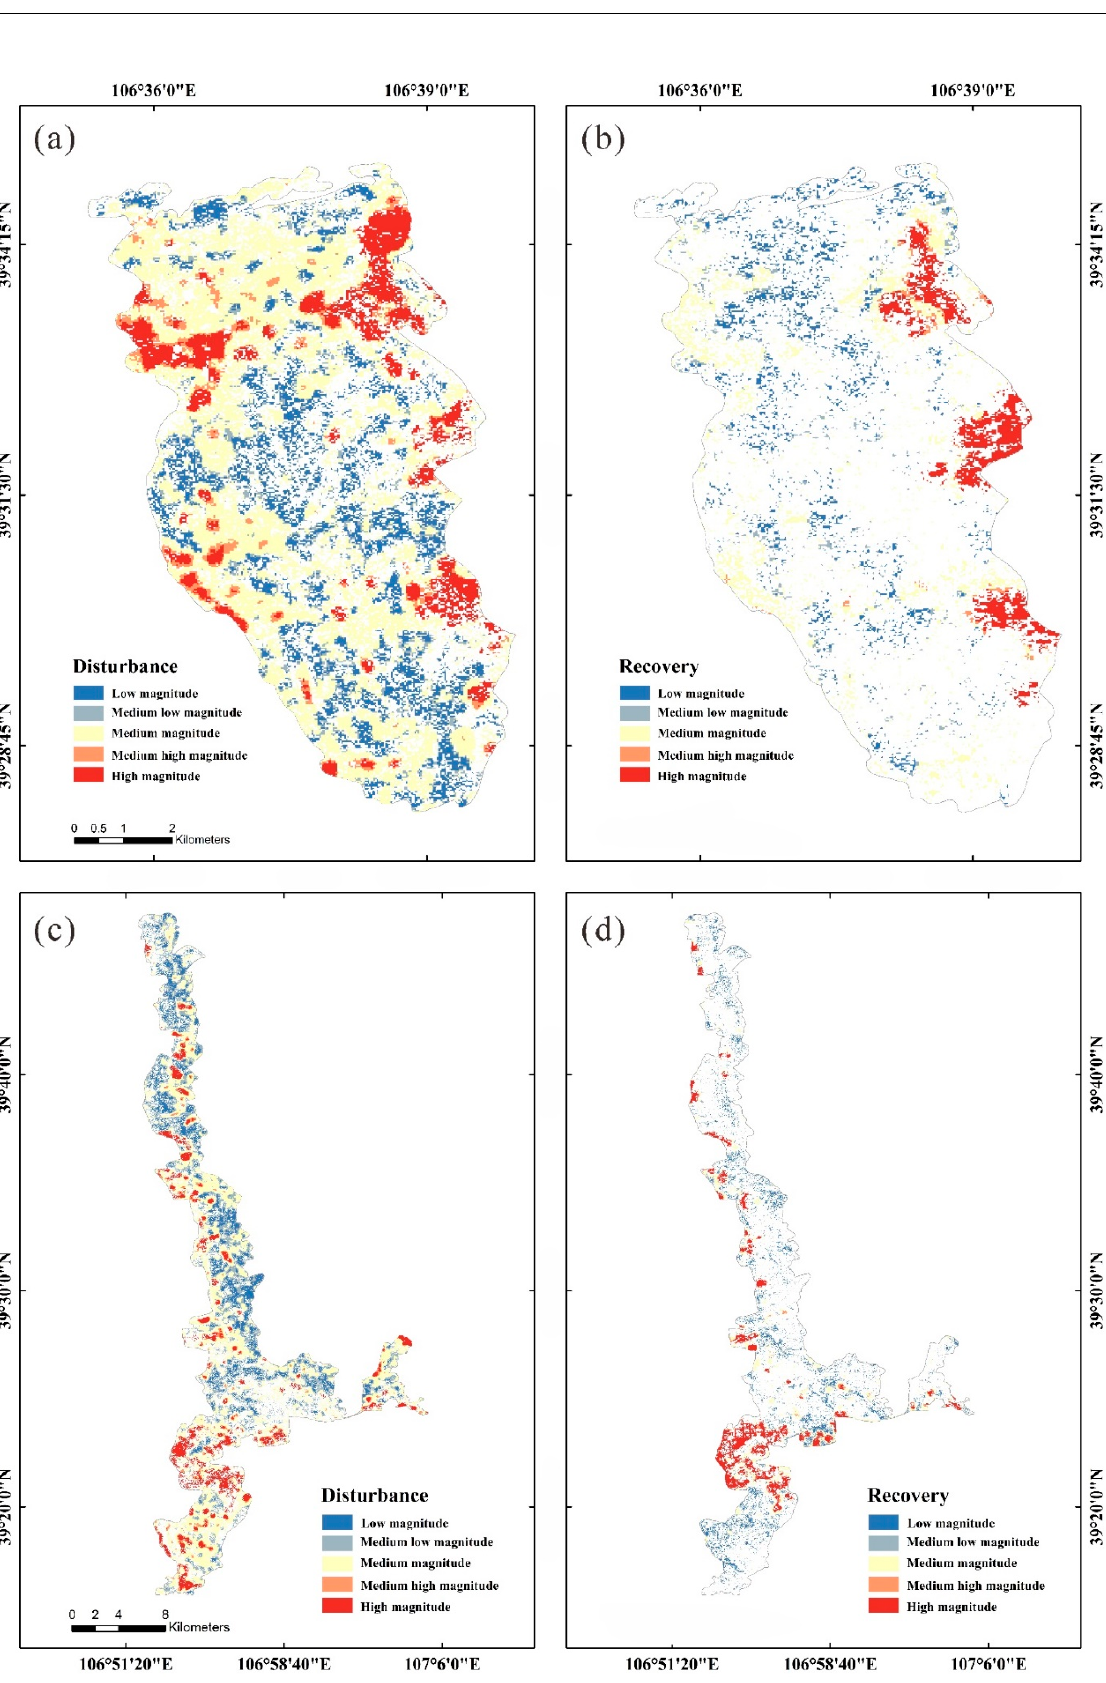
Figure 9. Spatial distribution of disturbance and recovery magnitude cold and hot spots. ( a ) disturbance in the western mine; ( b ) recovery in the western mine; ( c ) disturbance in the eastern mine; ( d ) recovery in the eastern mine.